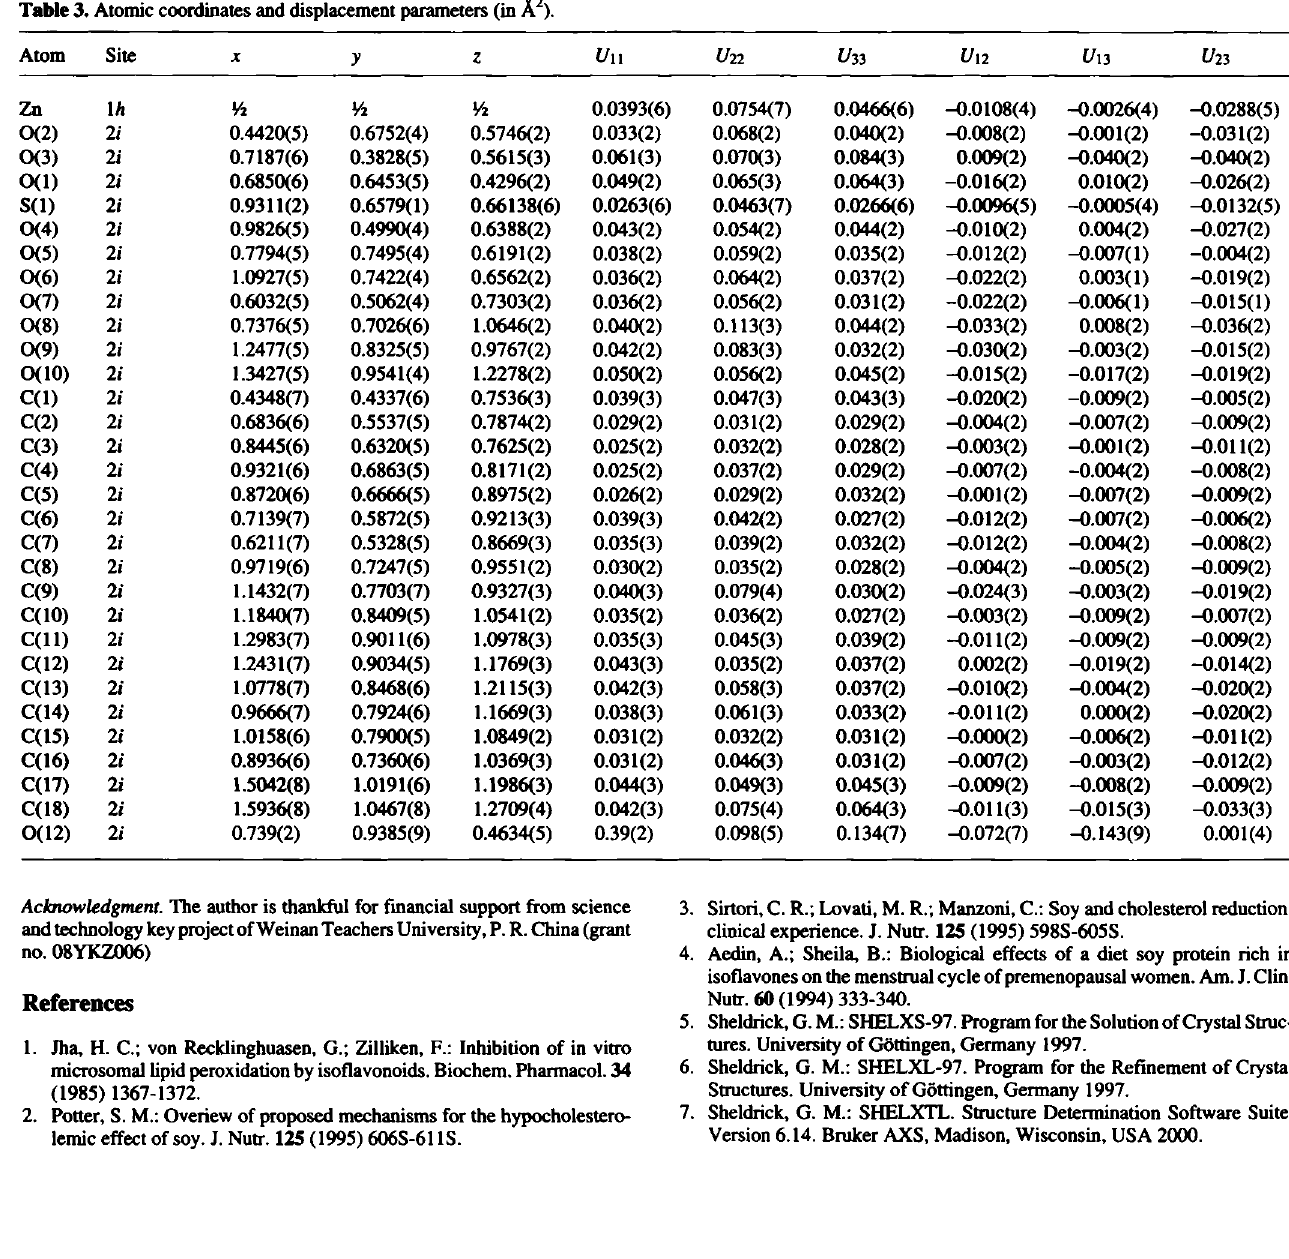
Table 3. Atomic coordinates and displacement parameters (in Â 2